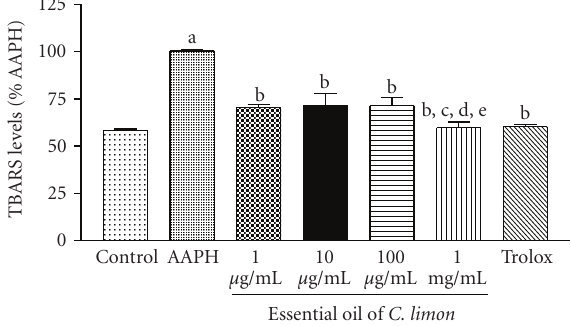
Figure 2: Thiobarbituric acid-reactive substances (TBARS) in vitro . A lipid-rich system was incubated with a free radical source (AAPH) and the e ff ect of di ff erent concentrations of EO on the lipoperoxidation was measured by quantifying TBARS. Control is incubation medium without AAPH; other groups contained AAPH alone or in the presence of di ff erent concentrations of EO. Trolox was used as standard antioxidant. Bars represent mean ± SEM. a P < . 001, when compared to control; b P < . 001, when compared to 1 μ g/mL; c P < . 001, when compared to 10 μ g/mL; d P < . 001, when compared to 100 μ g/mL; e P < . 001, when compared to 1 mg/mL. One-way ANOVA followed by Tukey’s multiple comparison post hoc test was applied to all